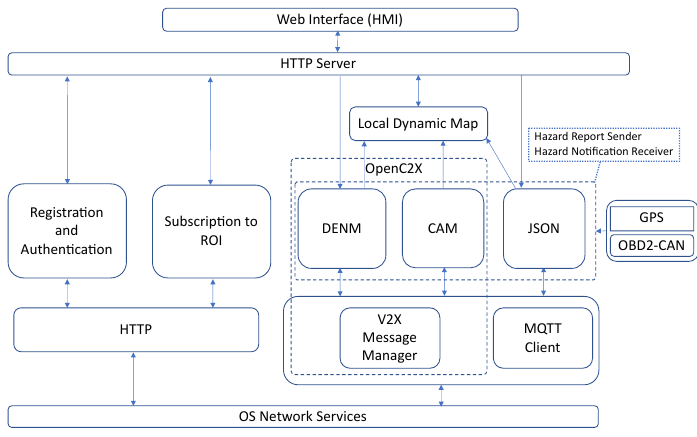
Figure 6. Software architecture of the OBU including the core modules of ETSI C-ITS stack, and other components to support UDP/HTTP and MQTT